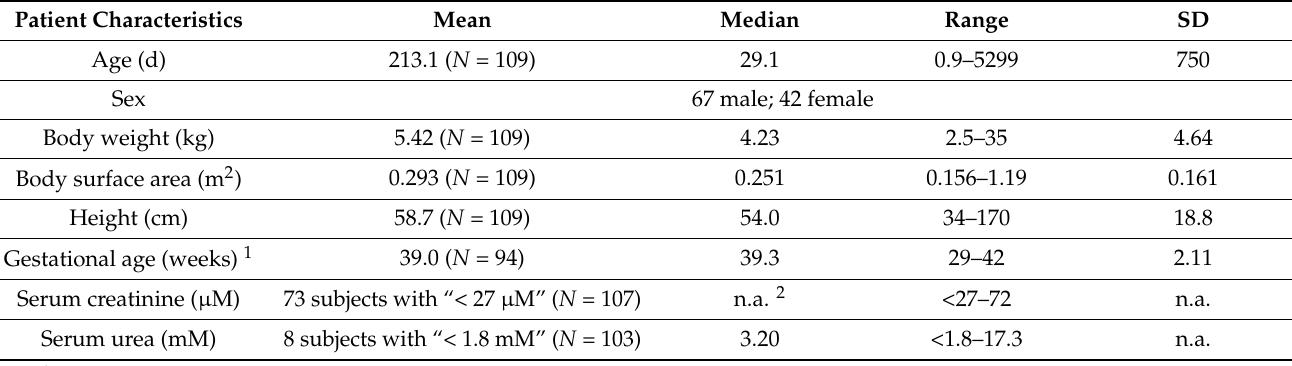
Table 1. Characteristics of the patient population, means (with N , number of subjects with available data), medians, ranges and standard deviations